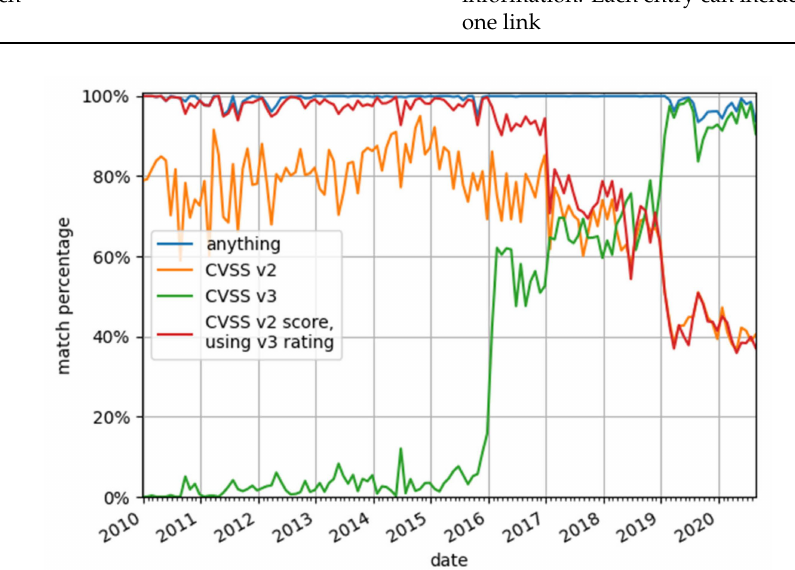
Figure 3. CNNVD severities matched with severities based on the NVD CVSS scores. Orange line—Matching with CVSS v2 rating. Green line—Matching with CVSS v3 rating Red line—Matching with rating based on CVSS v2 score but using CVSS v3 severity ratings. Blue line—Matching with any of the previous